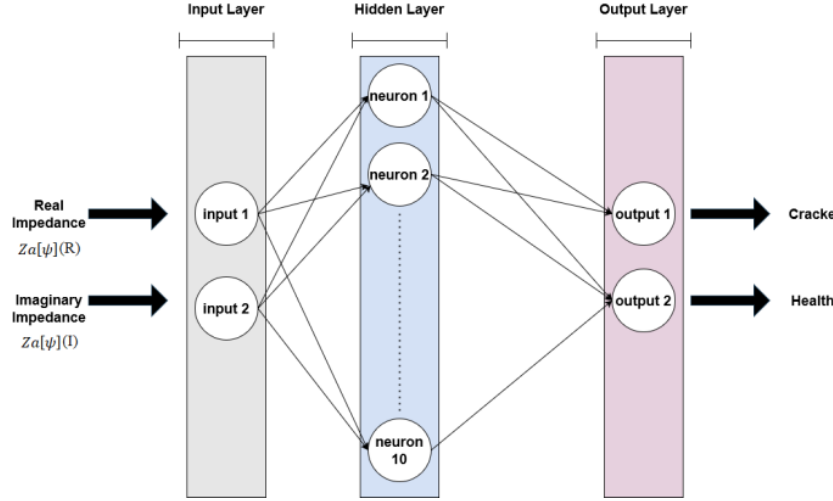
Figure 4. ANN structure used in the paper.